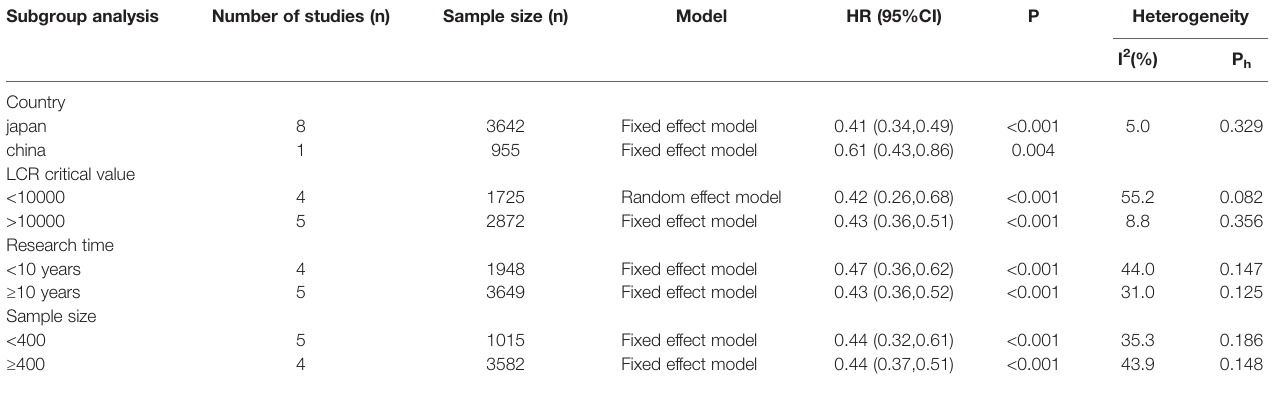
TABLE 2 | Subgroup analysis of relationship between LCR and